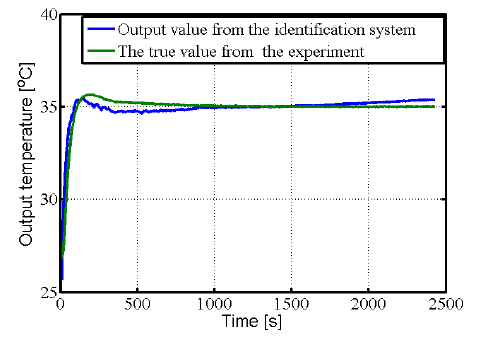
Figure 9. Comparison of the output value from the identification system and the true value from the